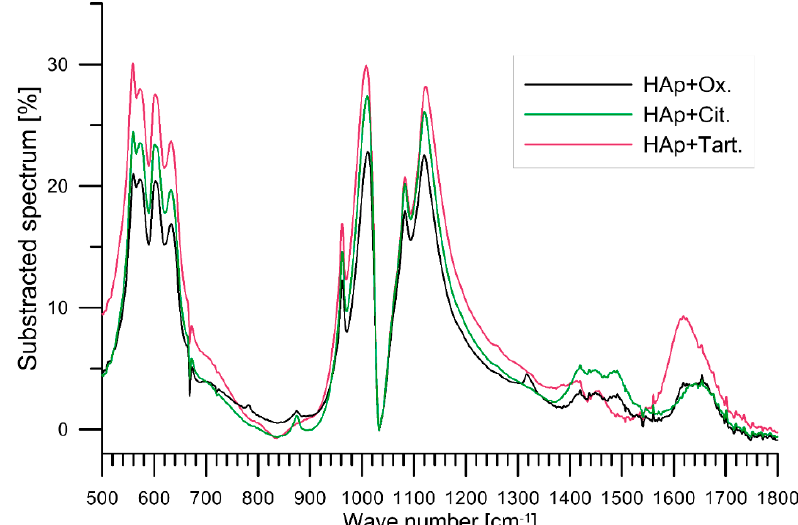
Figure 7. Comparison of the subtracted FTIR spectra of tartrate, citrate and oxalate ions adsorbed on hydroxyapatite.